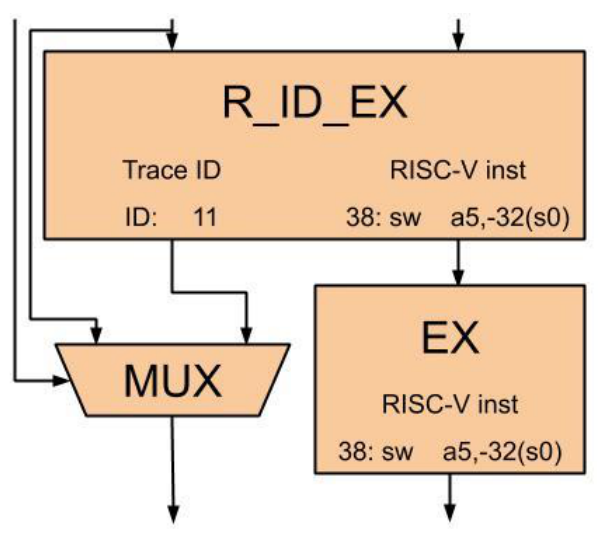
Figure 5. Trace’s instruction pair execution